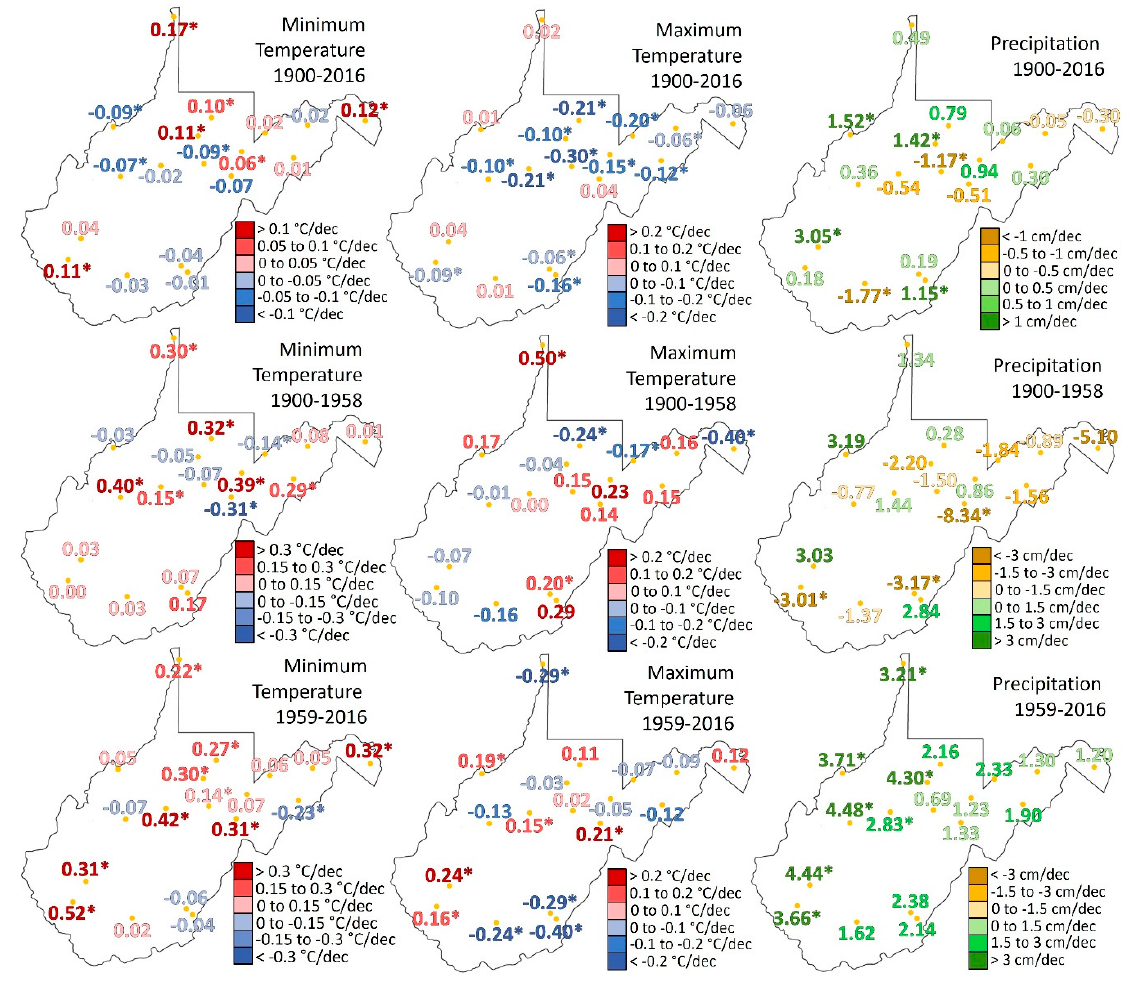
Figure 3. Sen’s slope estimator for minimum temperature (left), maximum temperature (middle), and precipitation (right) across the state of West Virginia, USA between 1900–2016 (top), 1900–1958 (middle), and 1959–2016 (bottom). * Indicates statistically significant trends (p < 0.05).